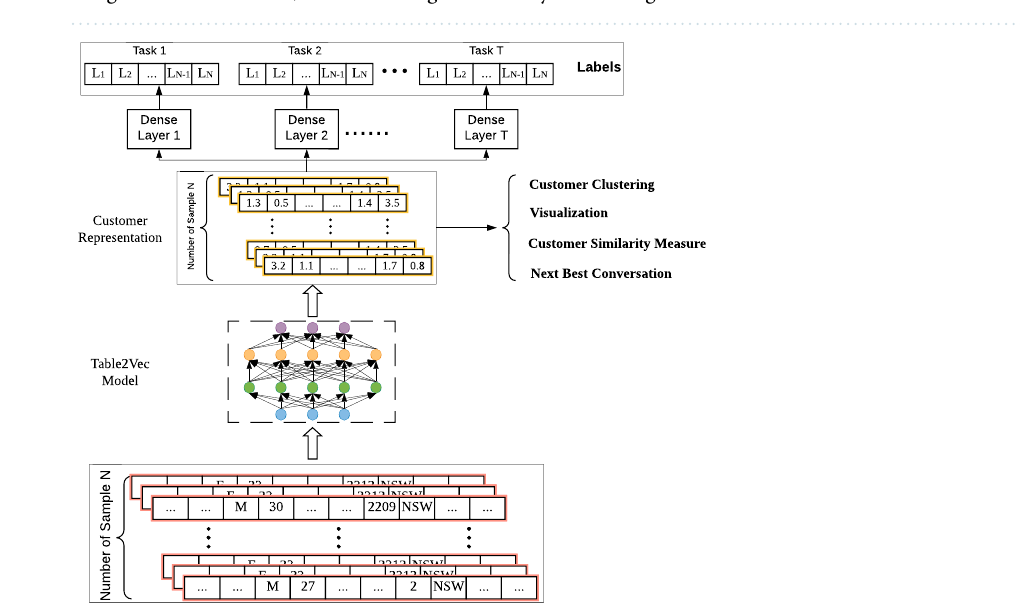
Figure 4. The neural framework of Table2Vec with automated data characteristics analysis and augmentation. NC-Recognizer automatically recognize and distinguish numerical and categorical features, SD-Recognizer automatically recognize and distinguish static and dynamic features, ND-Embedding vectorize dynamic numerical feature values, NS-Embedding vectorize static numerical feature values, CS-Embedding vectorize static categorical feature values, CD-Embedding vectorize dynamic categorical feature values.